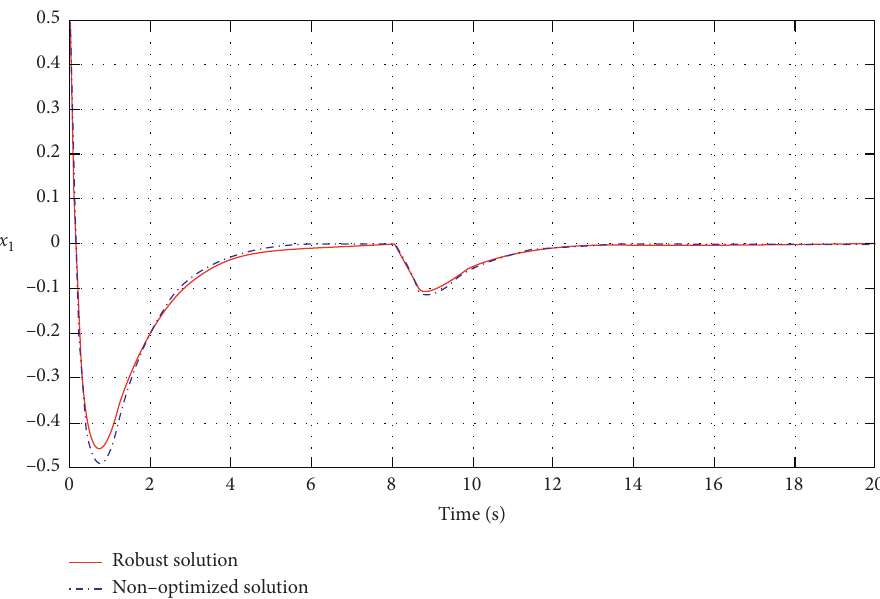
Figure 2: Comparison of x